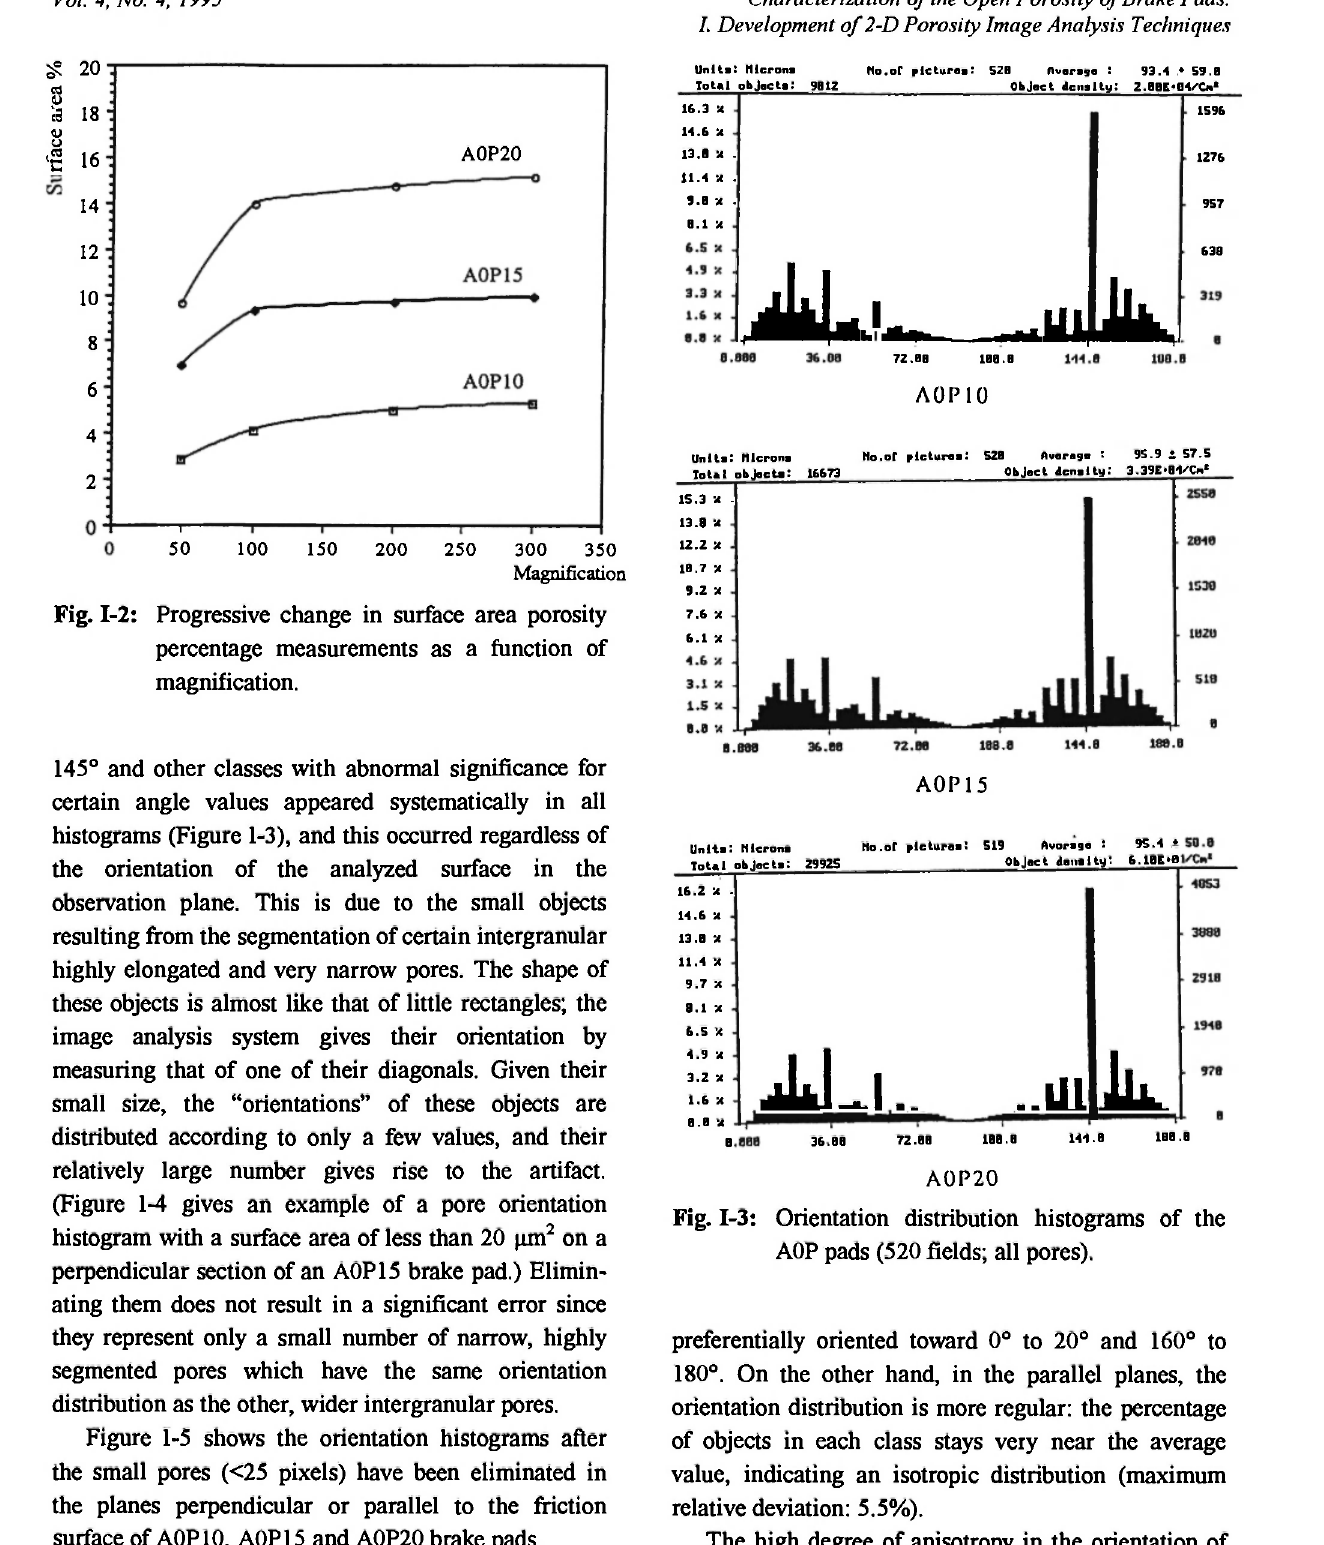
Fig. 1-2: Progressive change in surface area porosity percentage measurements as a function of magnification.